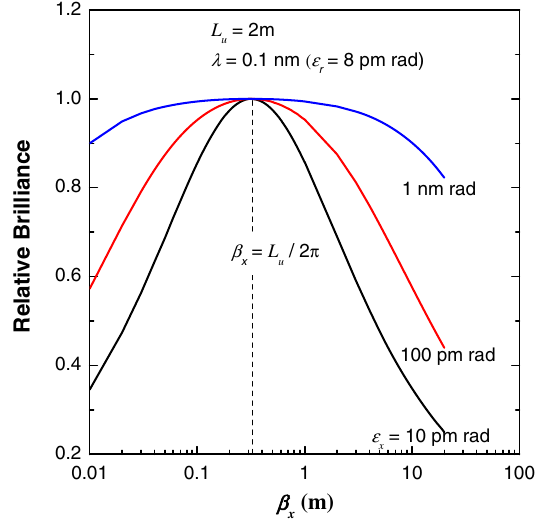
FIG. 10. Dependence of the relative brilliance on the horizontal betatron function for different electron